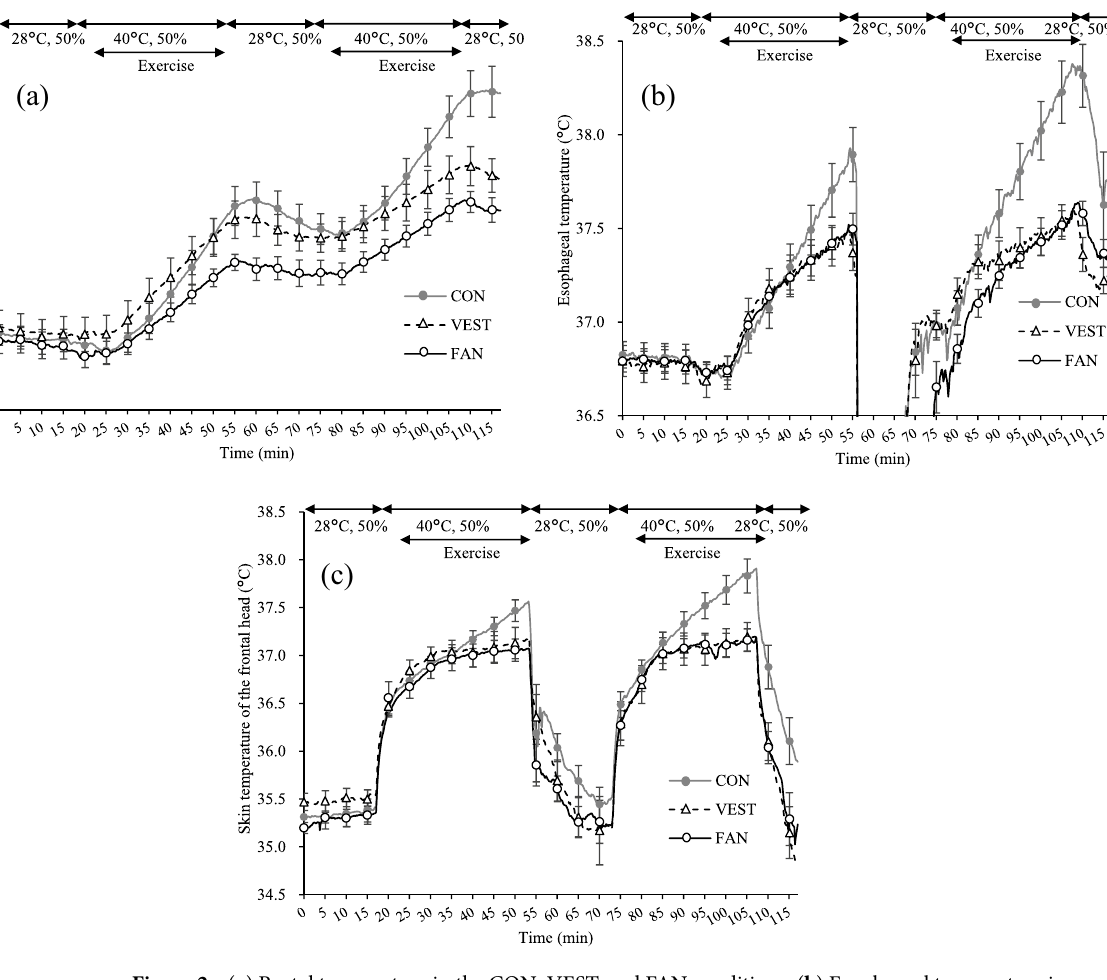
Figure 2. ( a ) Rectal temperature in the CON, VEST, and FAN conditions. ( b ) Esophageal temperature in the CON, VEST, and FAN conditions. ( c ) Skin temperature of the frontal head in the CON, VEST, and FAN conditions. Data at every 5 min are presented as the mean ± standard error. CON participants did not wear any cooling garment, VEST participants wore a circulating-water cooling vest, FAN participants wore a fan-attached jacket. Number of participants: nine, except for one missing T es datapoint in the CON